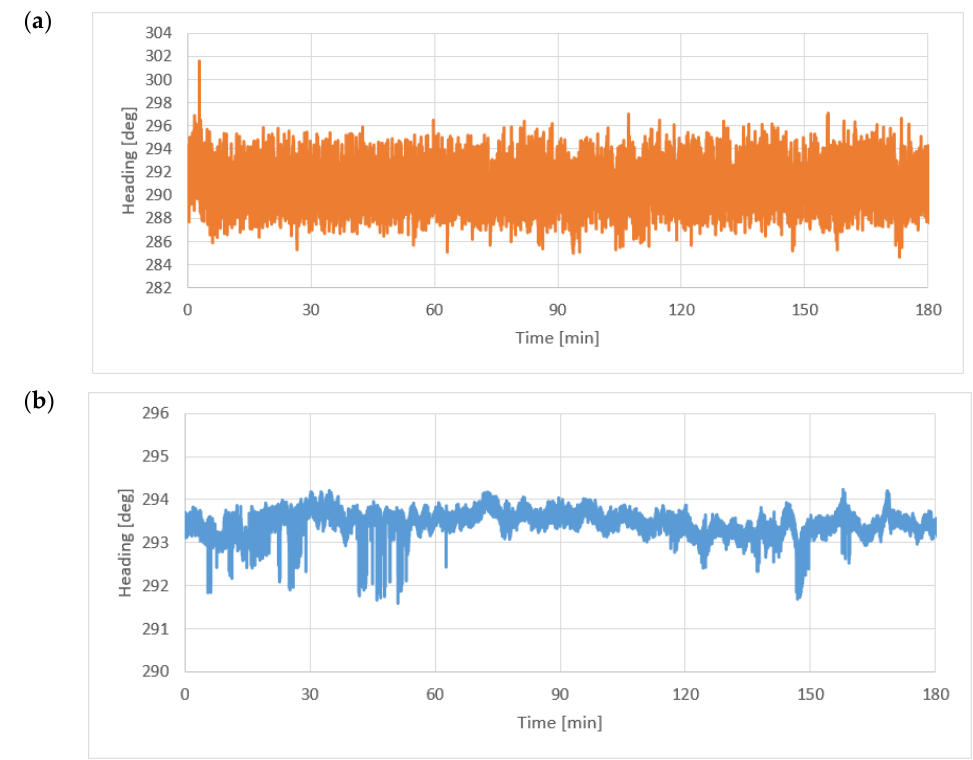
Figure 4. Static measurements of the course using a satellite compass ( a ) and a fluxgate ( b ).